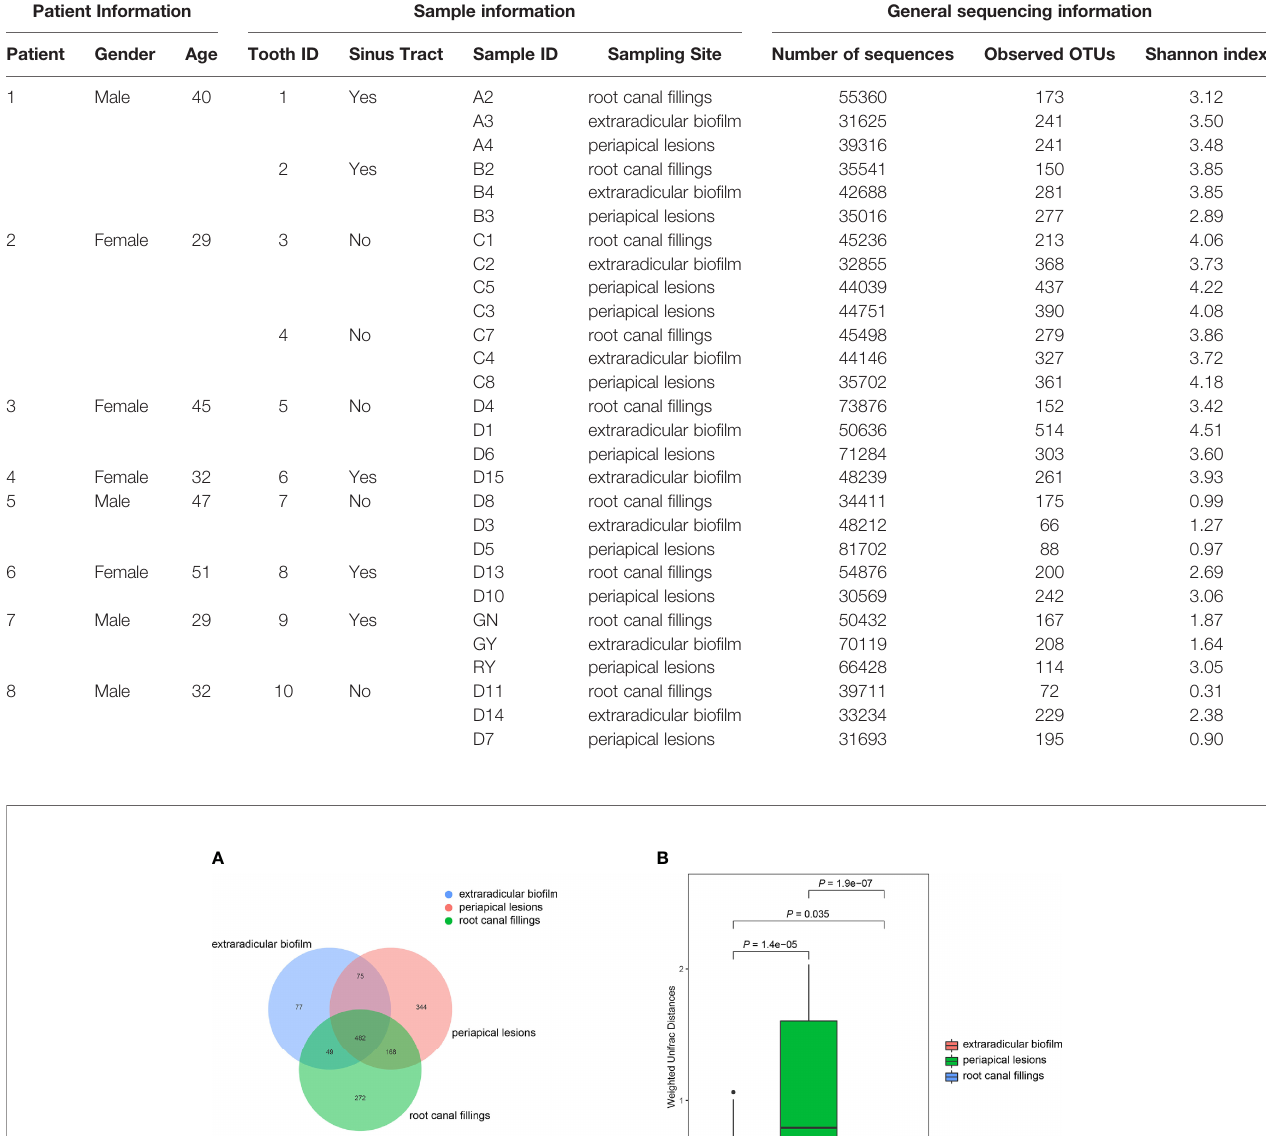
TABLE 1 | Sample information.